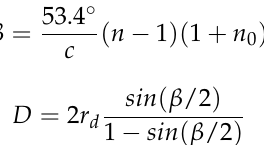
Figure 13. Schematic diagram of scanning trunk by camera.